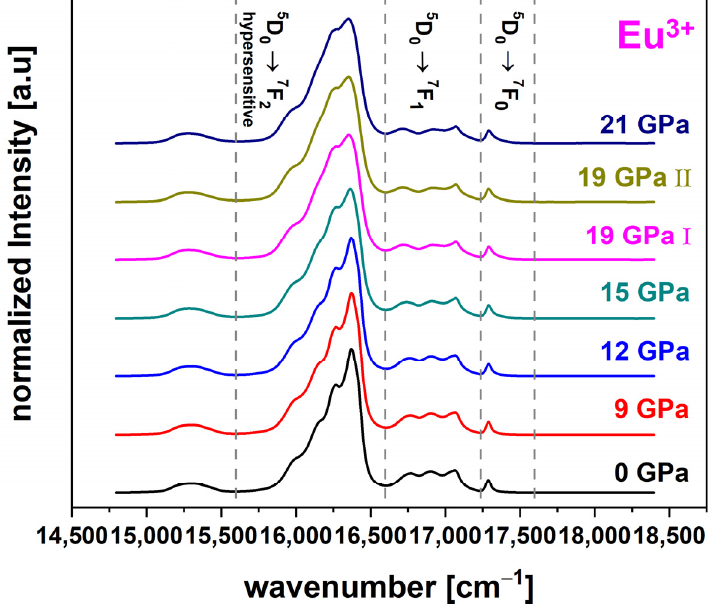
Figure 6. Exemplary luminescence spectra of the 5 D 0 → 7 F 0 (17,237 cm − 1 –17,597 cm − 1 ), 5 D 0 → 7 F 1 (16,597 cm − 1 –17,237 cm − 1 ) and hypersensitive 5 D 0 → 7 F 2 (15,597 cm − 1 –16,597 cm − 1 ) transition of the Eu 3+ -luminescence for the permanently densified glass (0 GPa to 21 GPa); spectra were acquired with a 532 nm laser and the shown frequency bands were used as anchor points for evaluation.